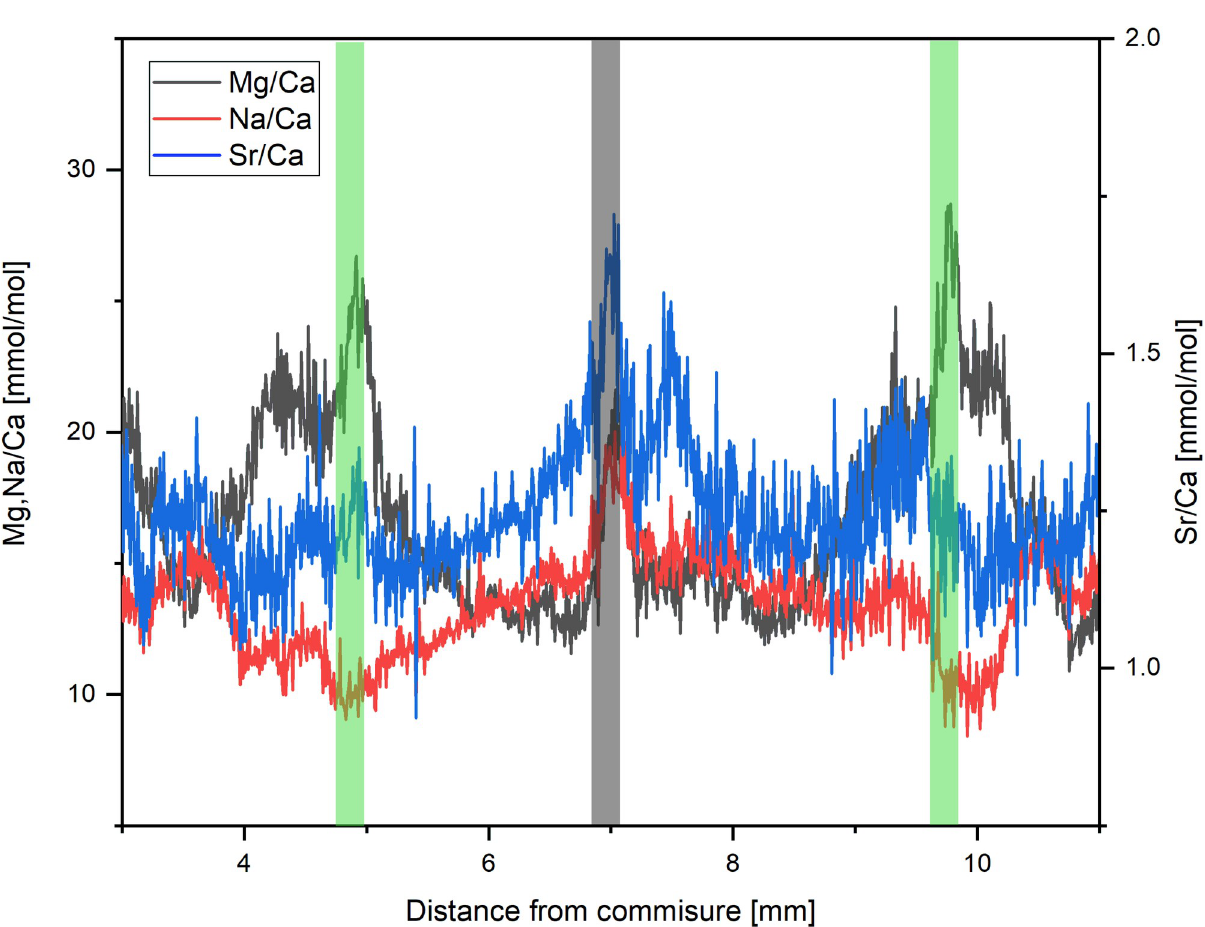
Fig 7. Mg/Ca Sr/Ca and Na/Ca ratios of sample 6R. The grey shaded area shows the location of a growth line, which demonstrates increases in all elemental ratios. Green shaded areas show high Mg/Ca winter values. Here increases of Mg/Ca and Sr/Ca are visible whereas Na/Ca is decreasing.